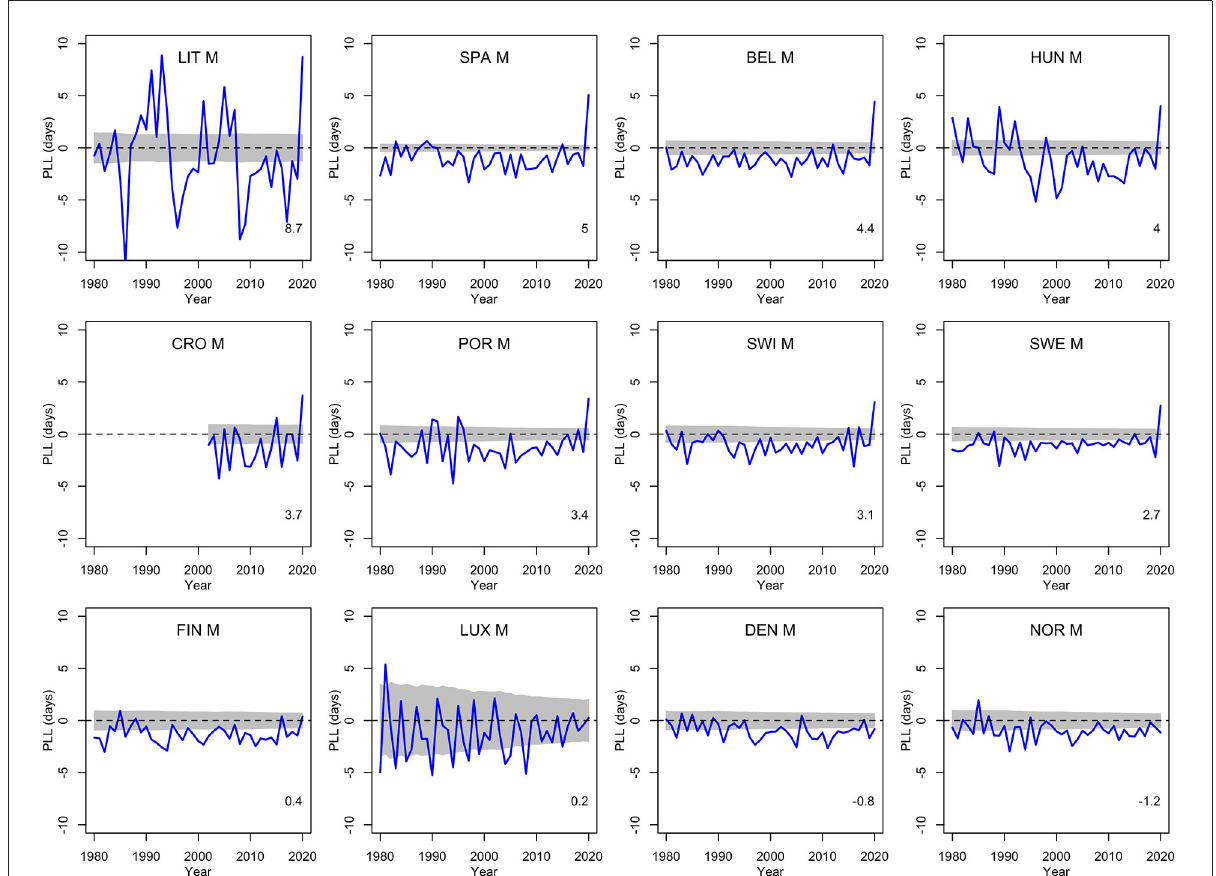
FIGURE1 Population life loss ( PLL y ) in years y between 1980 and 2020 for men (M) of 12 European countries, together with 95% prediction intervals calculated under the null hypothesis of a similar mortality as the year before. At the bottom, population life loss in 2020 ( PLL 2020 , expressed in days) is